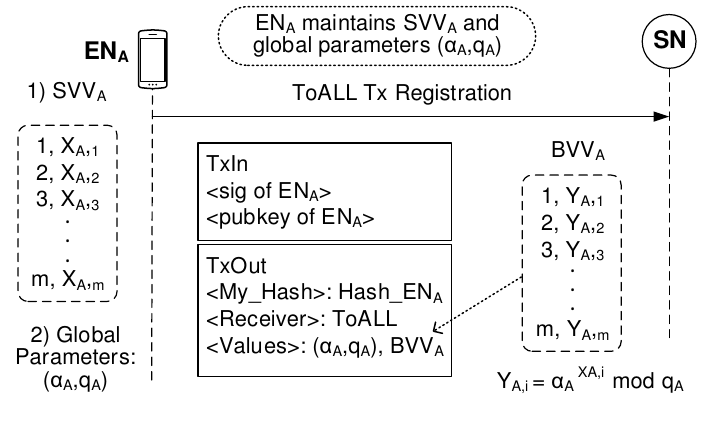
Figure 6. ToALL Tx registration.